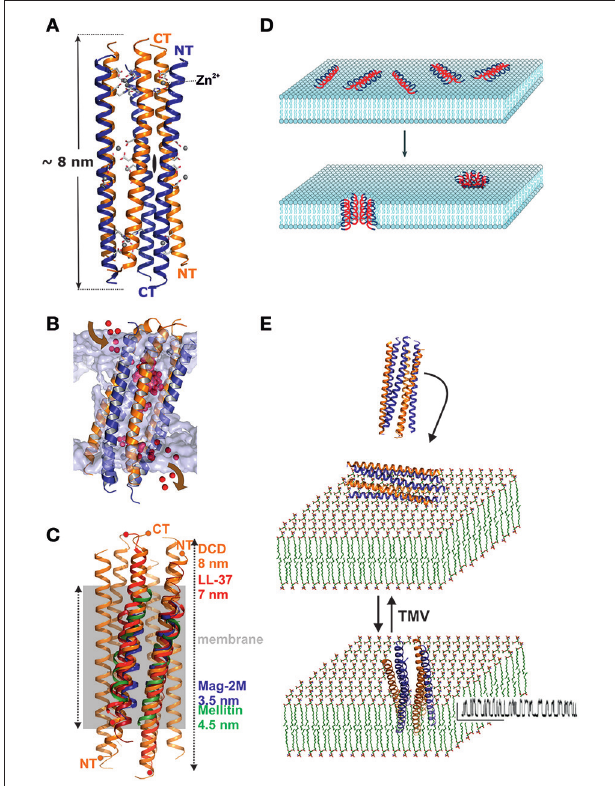
FIGURE 1 | Structure and functional mechanism of human dermcidin. (A) Side view of the hexameric structure of dermcidin shown in ribbon representation. The peptide forms regular helixes which are arranged in an anti-parallel manner (highlighted in blue and orange) so that the channel consists of a trimer of dimers which are aligned along the three-fold axis of the channel. The overall length of the channel is 8nm and zinc binding (Zn 2 + ) sites are located at the end of the channel located between two helices. (B) Molecular dynamic studies of DCD in artificial membranes demonstrate an unexpected pathway of ion translocation. Ions enter the channel from the side of the membrane at the height of the membrane lipid head groups and leave the channel by the same mechanism. Due to the extension of the channel and the hydrophobic exterior, the energetically most favorable conformation is a tilted channel (20–30 ◦ relative to the membrane normal) in the membrane. (C) Mechanism of DCD interaction with membranes: the channel exists as a stable hexamer in solution. Interaction of the channel with the membrane does not lead to insertion unless a transmembrane voltage of > 100mV moves the channel into the membrane. Although small, the channel shows clear and defined conductivity steps with a high open probability [see also (E) ]. (D) Simplified mechanism describing the carpet model which explain the activity of AMPs which are in a first step electrostatically attracted by membranes followed by an assembly of peptides and integration into lipid bilayers (Brogden, 2005). This figure is reprinted with permission from Brogden (2005). (E) By contrast, dermcidin is already oligomeric in solution and interacts with membranes via electrostatic interactions. Integration of the peptide cannot be detected in biophysical studies unless a transmembrane voltage (TMV) is applied which leads to the detection of a conductive channel (Song et al., 2013).